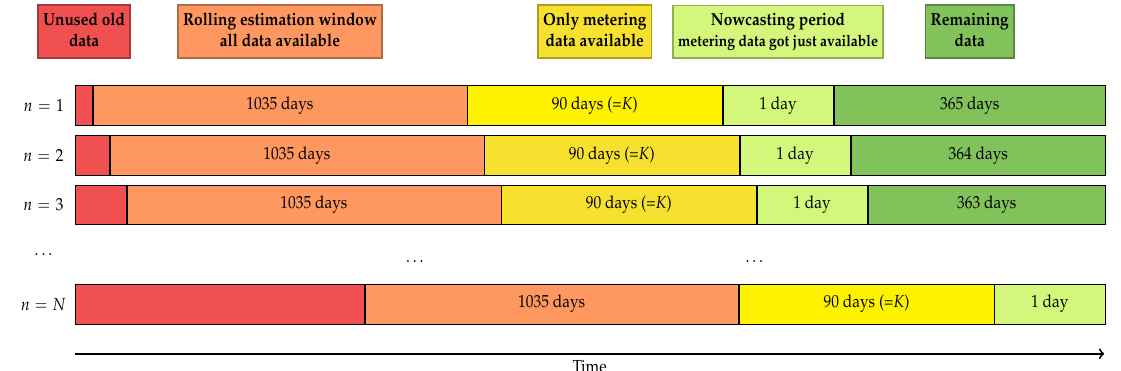
Figure 3. Illustration of the nowcasting study design.